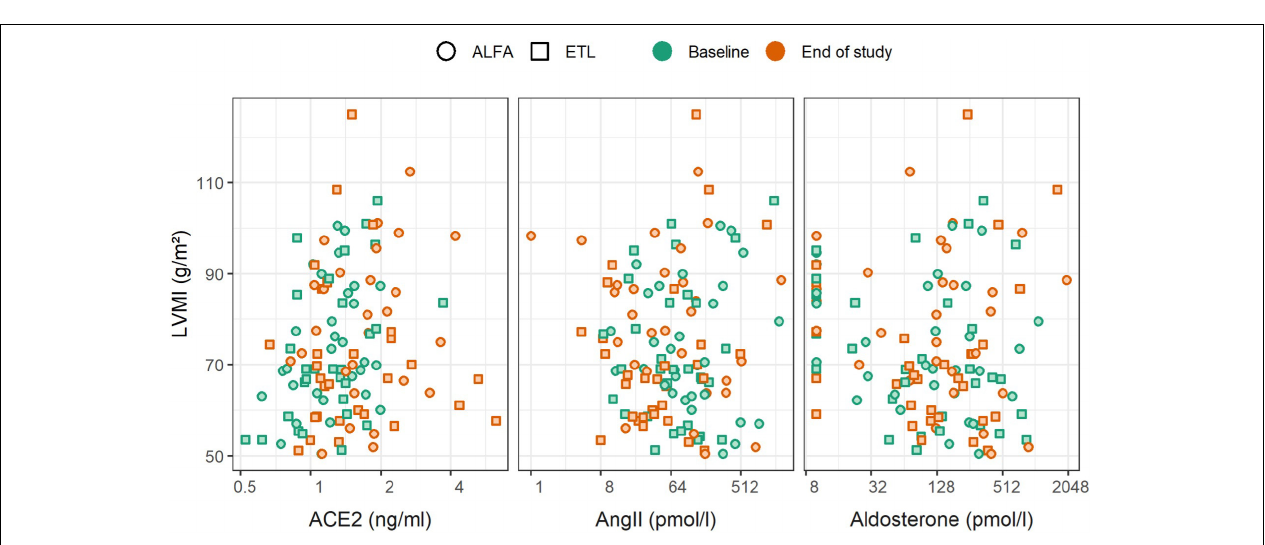
FIGURE 4 | Scatterplot of renin-angiotensin-aldosterone system (RAAS) parameters and left ventricular mass index (LVMI), stratified by time of measurement (color) and study drug (shape). Changes of RAAS parameters were not associated with changes of